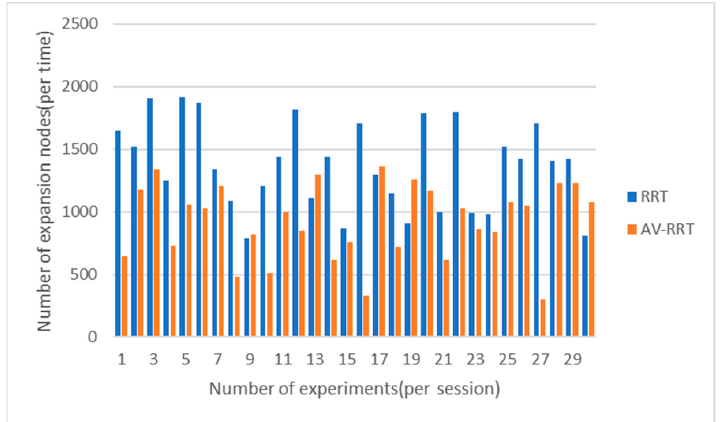
Figure 14. Comparison of number of extended nodes in scene with sparse obstacles.